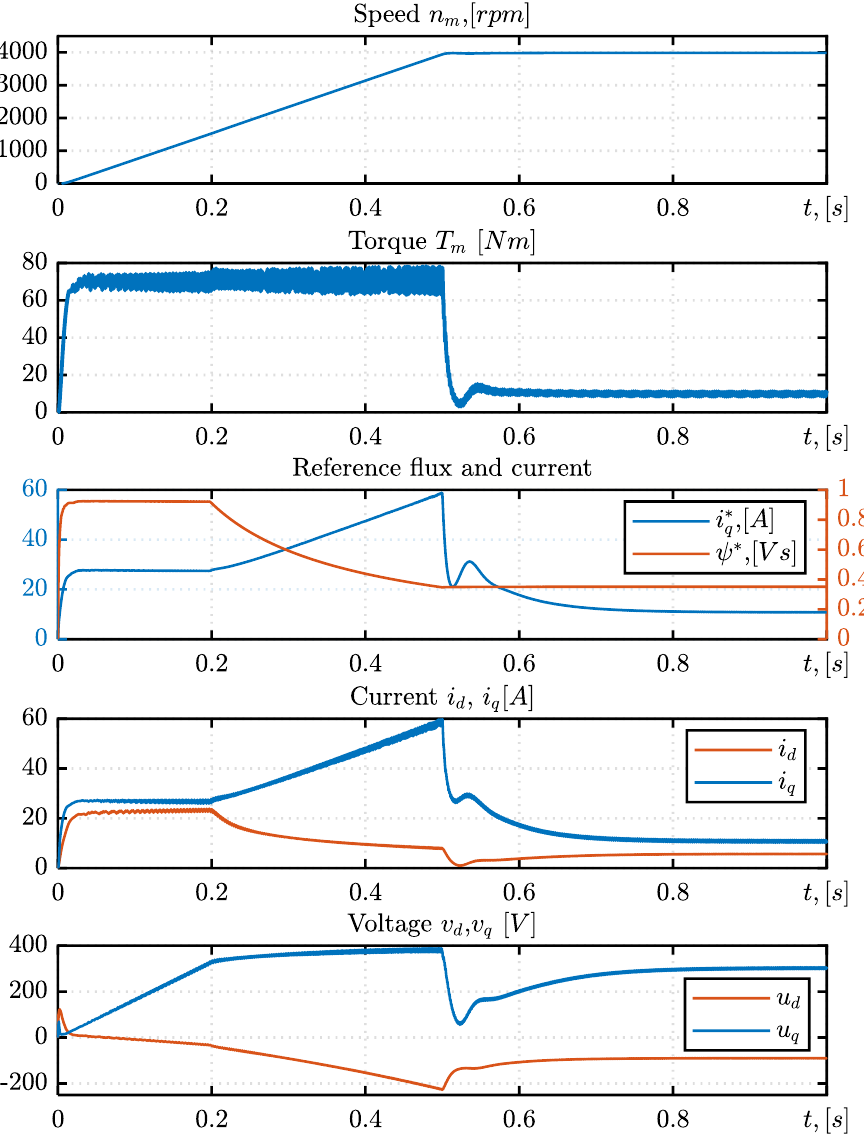
Figure 20. Drive performance in the speed control from zero to 4000 rpm (flux-weakening). The iron losses were computed in order to show that, during FW operations, the iron losses increase even if the main flux decreases [28]. The variation of iron losses in dependency on drive speed is shown in Figure